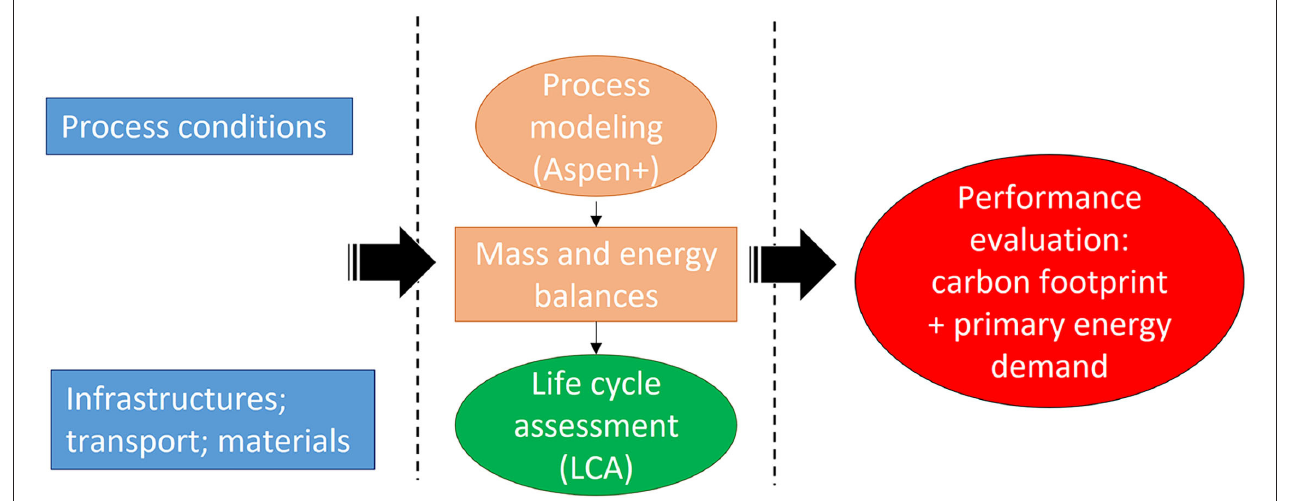
FIGURE 1 | General methodological